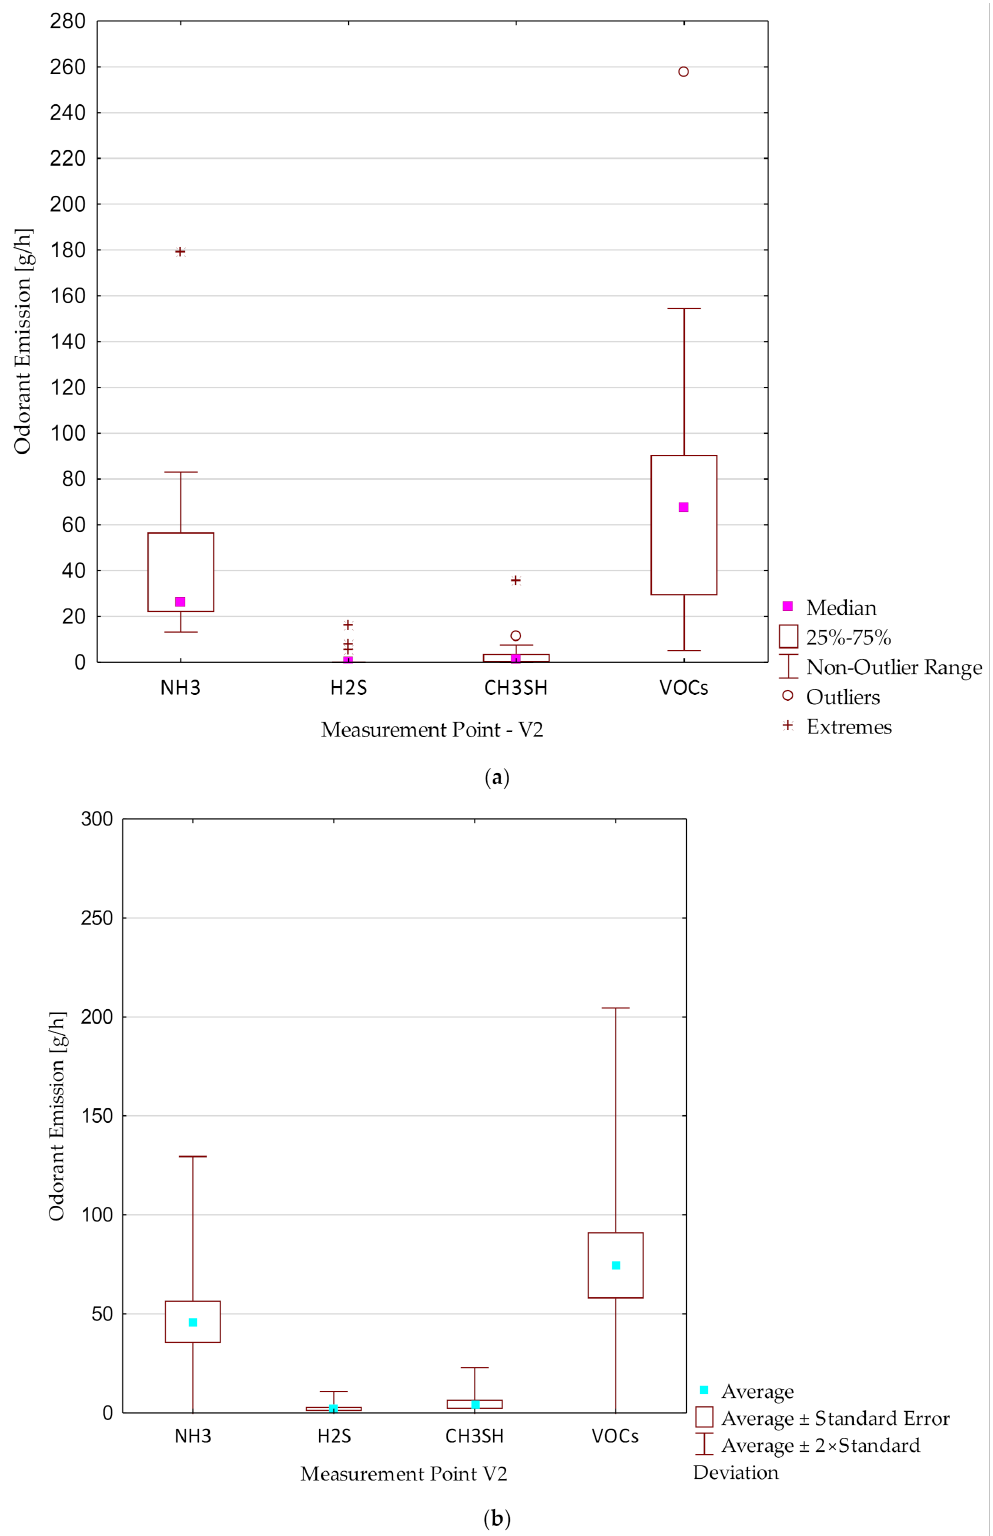
Figure 4. Odorant emission levels with median ( a ) and average ( b ) values at the second point (above the overhead conveyor transporting MSW) in every measurement